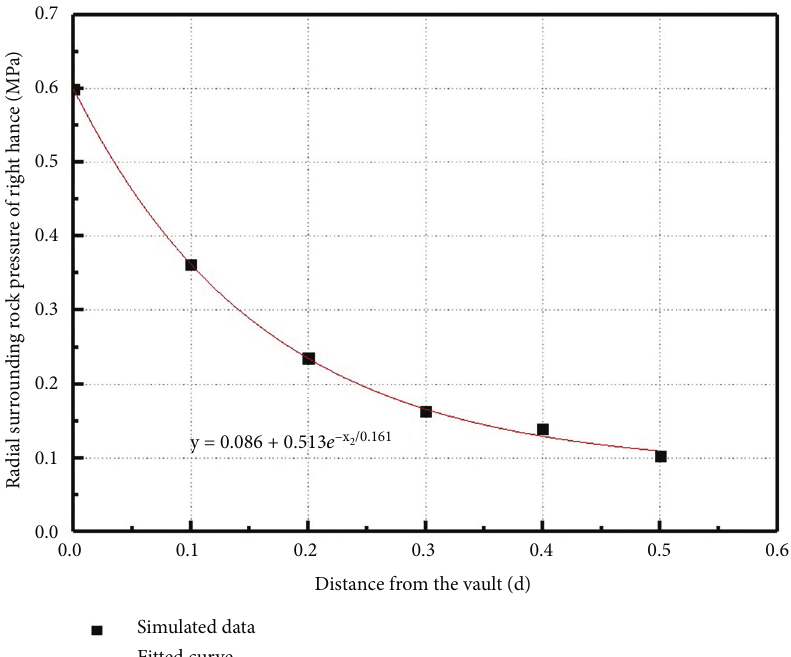
Figure 8: Fitting curve of the relationship between the surrounding rock pressure of right hance and the weak interlayer at di ff erent locations.